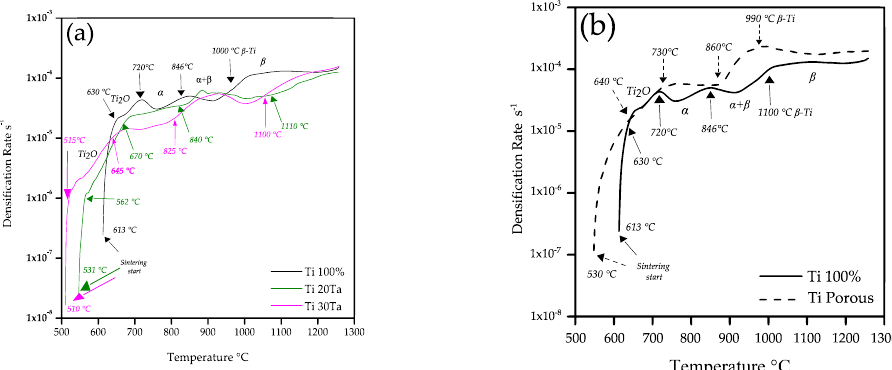
Figure 2. Strain as a function of temperature during the whole thermal cycle for ( a ) Ti-xTa samples; ( b ) Ti-xTa with 30 vol.% pore formers; and ( c ) Ti-xTa with 40 vol.% pore formers.